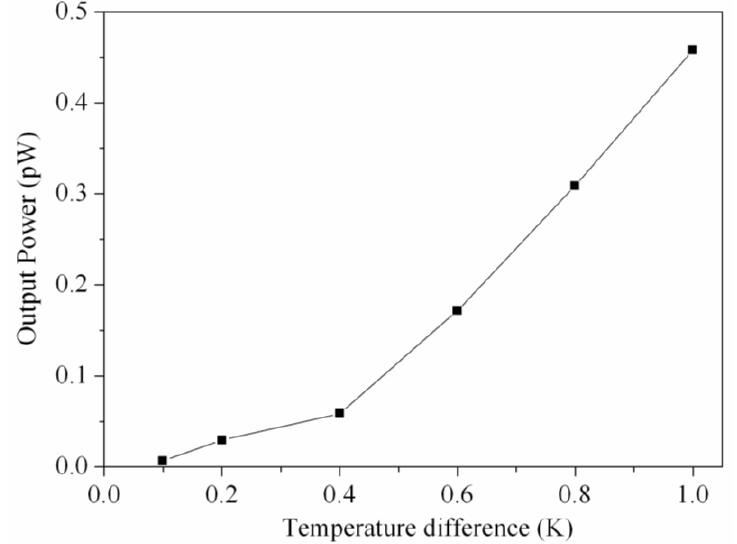
Figure 10. Output power of the